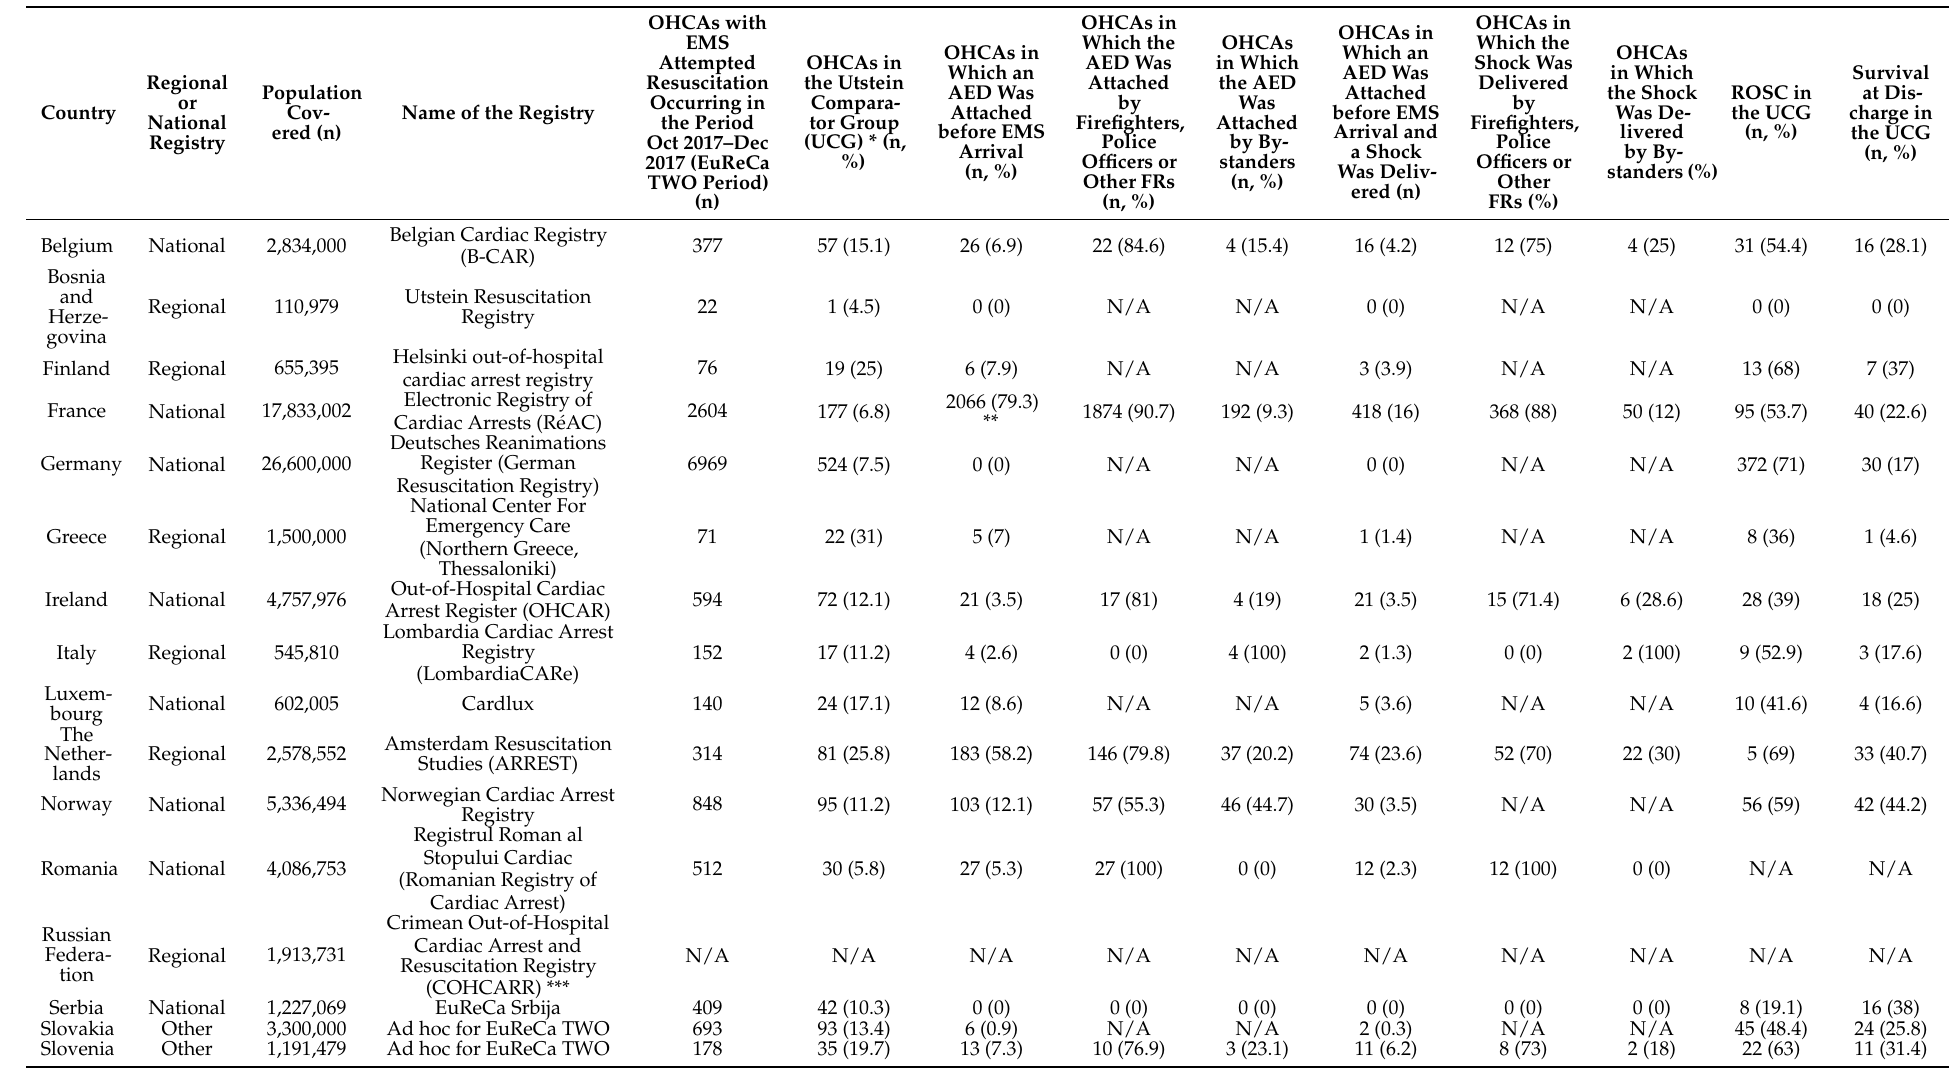
Table 2. Number of OHCAs, AED use, ROSCs and survival across the different European countries during the EuReCa TWO period (October 2017–December